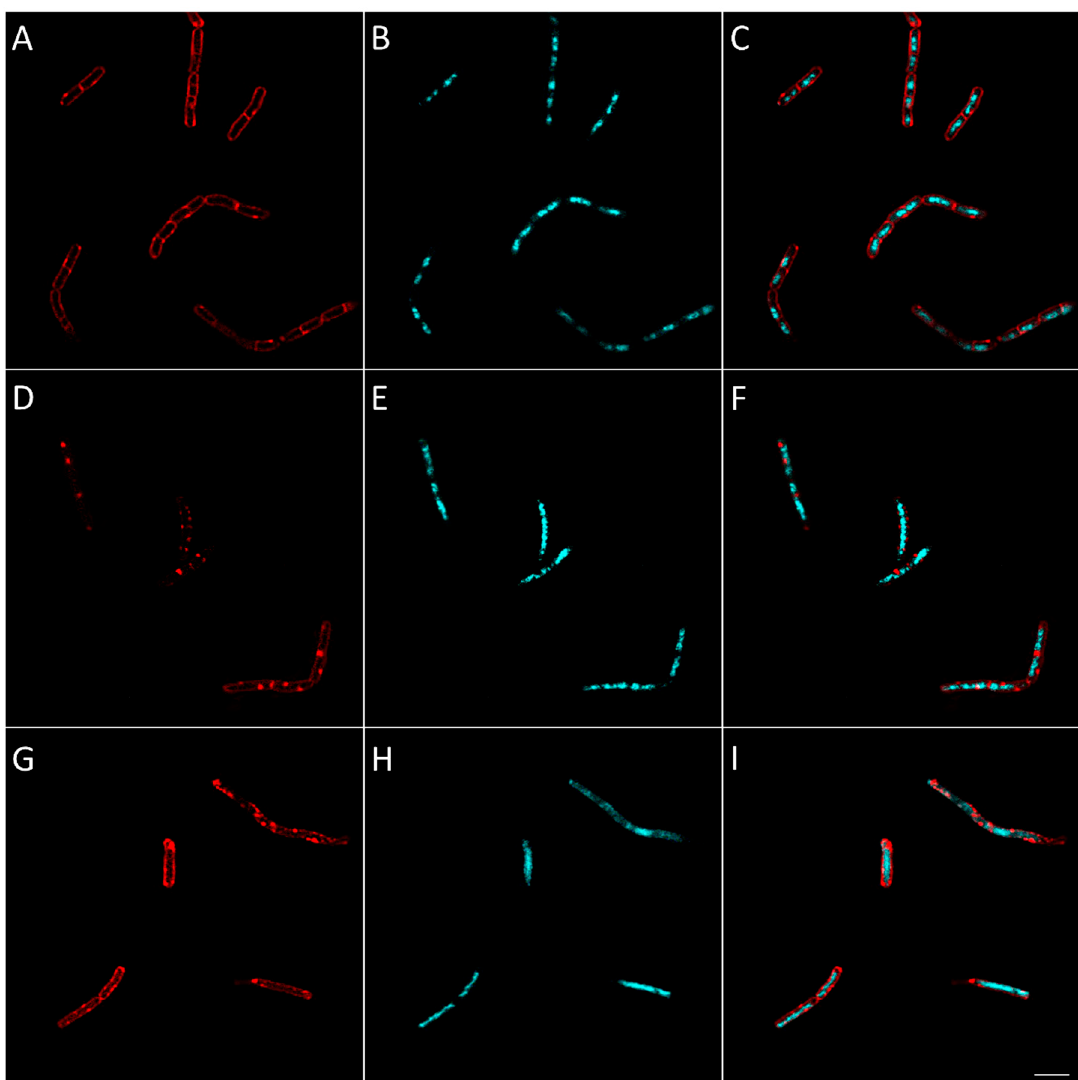
Figure 12. Morphological bacterial changes caused by compound 25 in V. alginolyticus. Morphological changes of V. alginolyticus caused by compound 25 were studied as explained in the Materials and Methods section. V. alginolyticus was incubated for 2 h at 37 °C in aerobic conditions with 4 X MIC of 25 ( D – F ). Control ( A – C ) was bacteria with no antibiotics added. At the end of the incubation, bacteria were fixed and membrane ( A , D , G ) and DNA ( B , E , H ) were stained using FM4-64FX (red signal) and DAPI (blue signal), respectively. Membrane and DNA signals were merged in the figure in ( C , F , I ). The effect of rifampicin, inhibiting RNA synthesis, is shown for comparison in ( G – I ). Bacteria were observed using confocal microscope and images representative of observed effect were taken. The white scale bar on the bottom right corner corresponds to 4 µm.